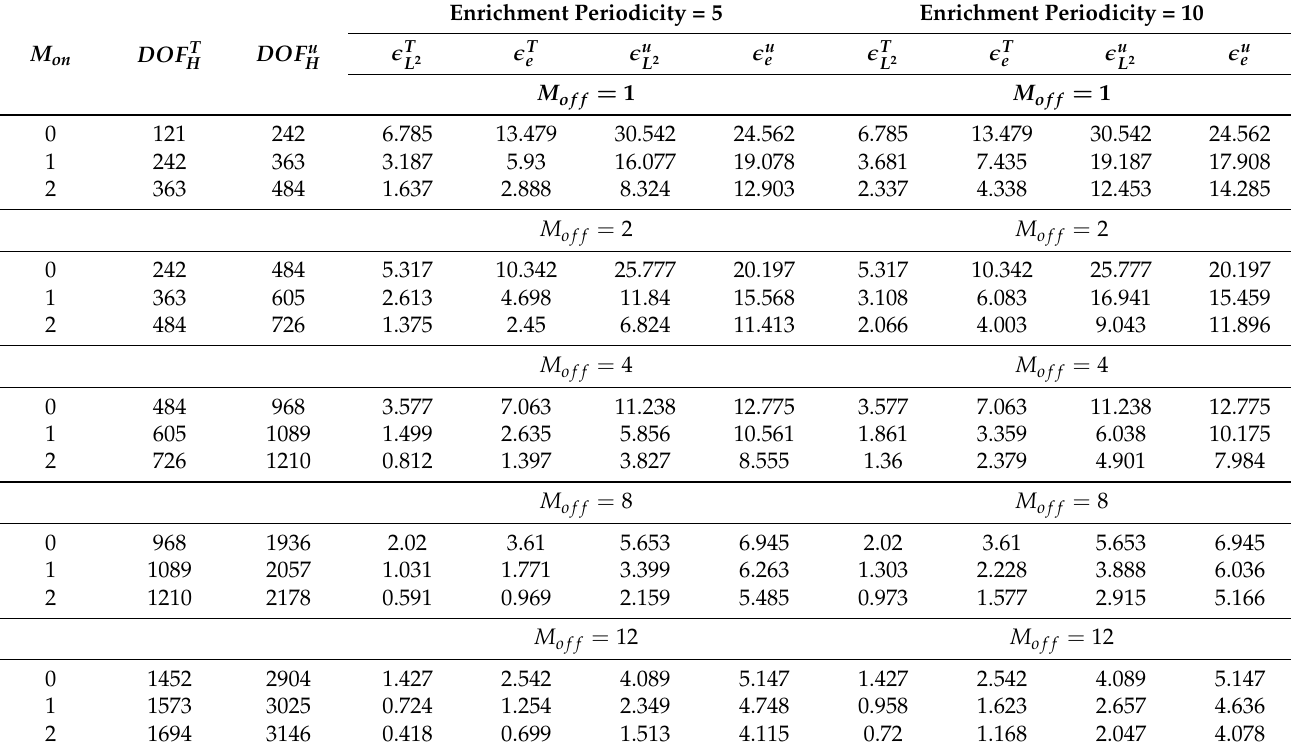
Table 1. Relative errors (%) for temperature and displacements with various numbers of offline and online basis functions ( M of f and M on ). Online basis functions are updated every 5 and 10 time steps (left and right,